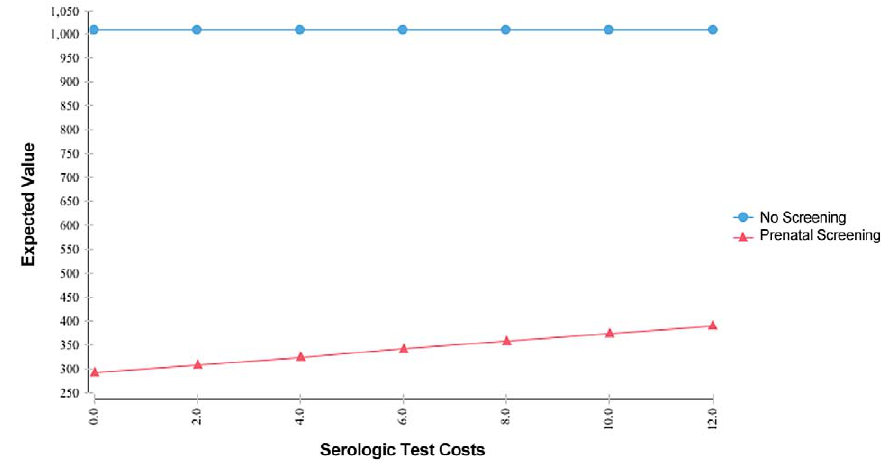
Figure 8. Sensitivity analysis on serologic test costs.